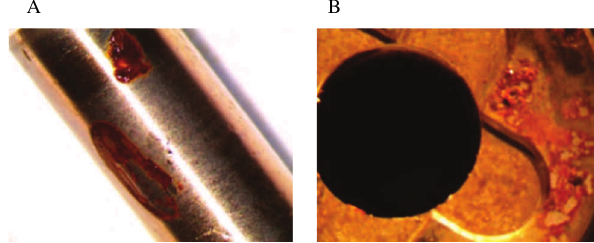
Fig. 8. A – precision element of injector needle, B – sealing surface on injector body between injector nozzle and injector body